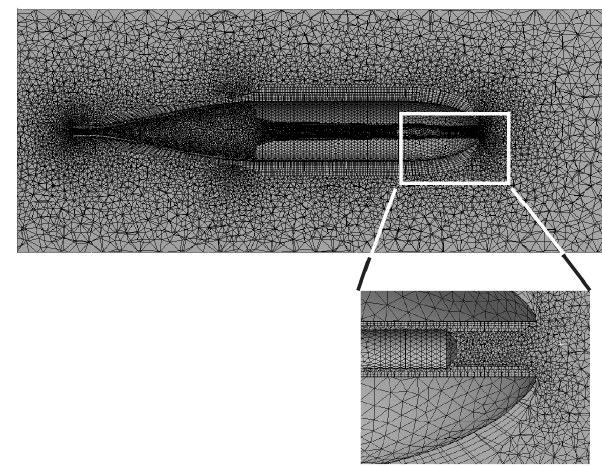
Fig. 1 – Image of the computational mesh with a close up view of elements near the probe nose.